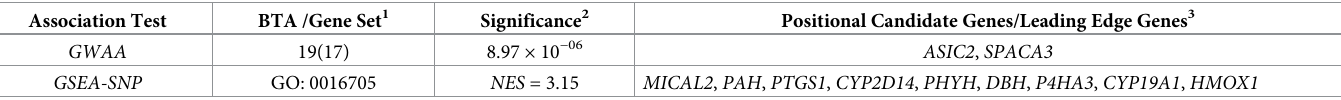
Table 1. Loci, gene-sets, and leading edge genes associated with the number of services required to successfully conceive and maintain pregnancy (TBRD) for 300 crossbred Angus/Salers